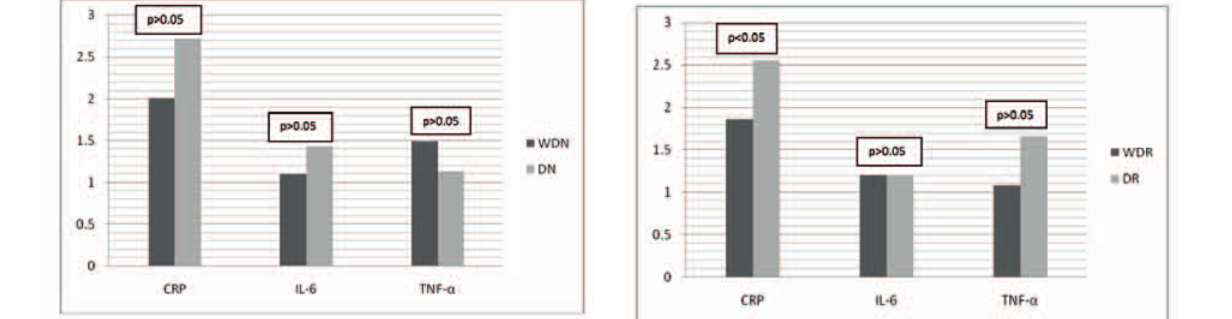
Figure 2. IInfl ammatory cytokines and diabetic retinopathy WDR – without diabetic retinopathy; DR – diabetic retin-